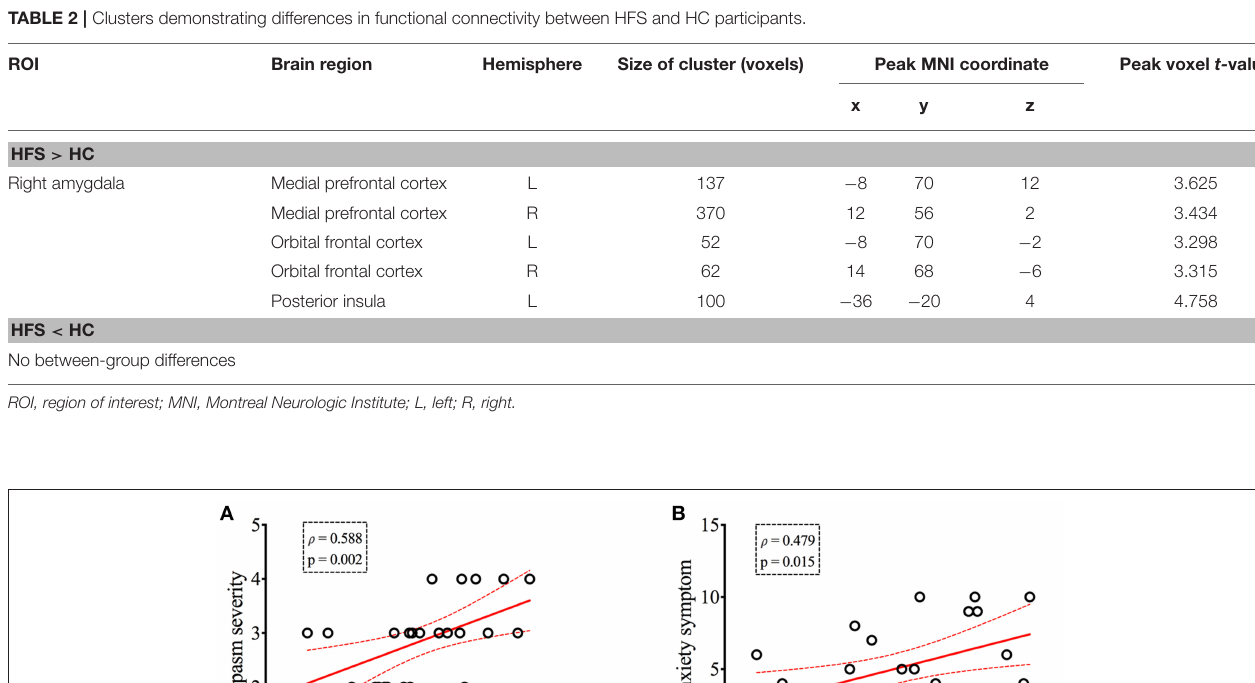
TABLE 2 | Clusters demonstrating differences in functional connectivity between HFS and HC participants.